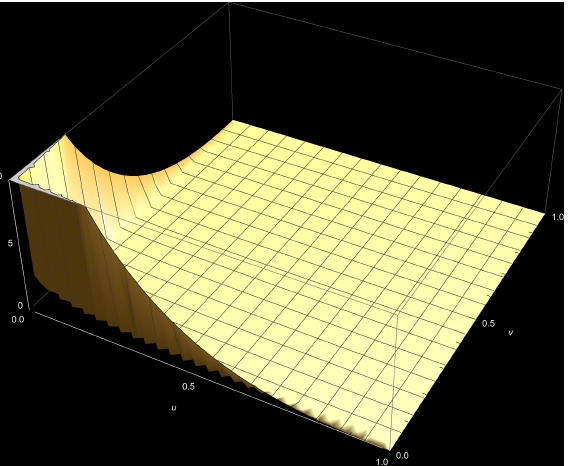
Figure A4. The bivariate Kumaraswamy contour (Equation (1)) plot, where α = 0.8, β = 0.8, θ = 0.2 and δ = 3.